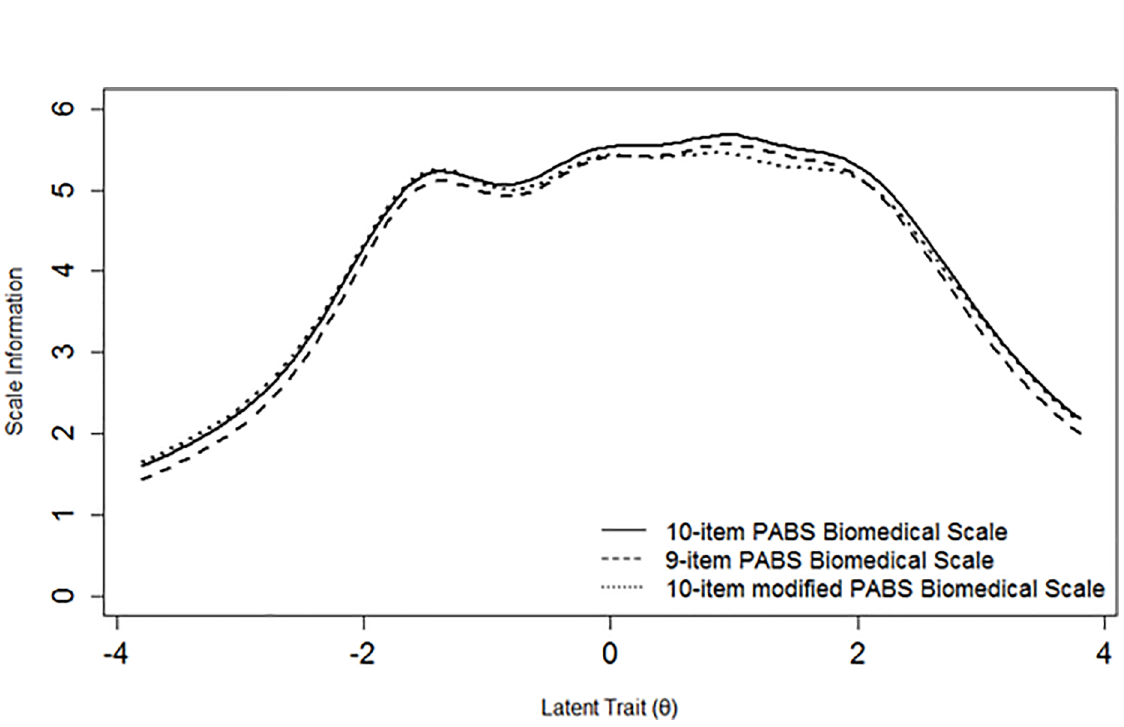
Fig 2. Scale information functions for three versions of the biomedical scale of the Pain Attitudes and Beliefs Scale (PABS) in the BeBack study.